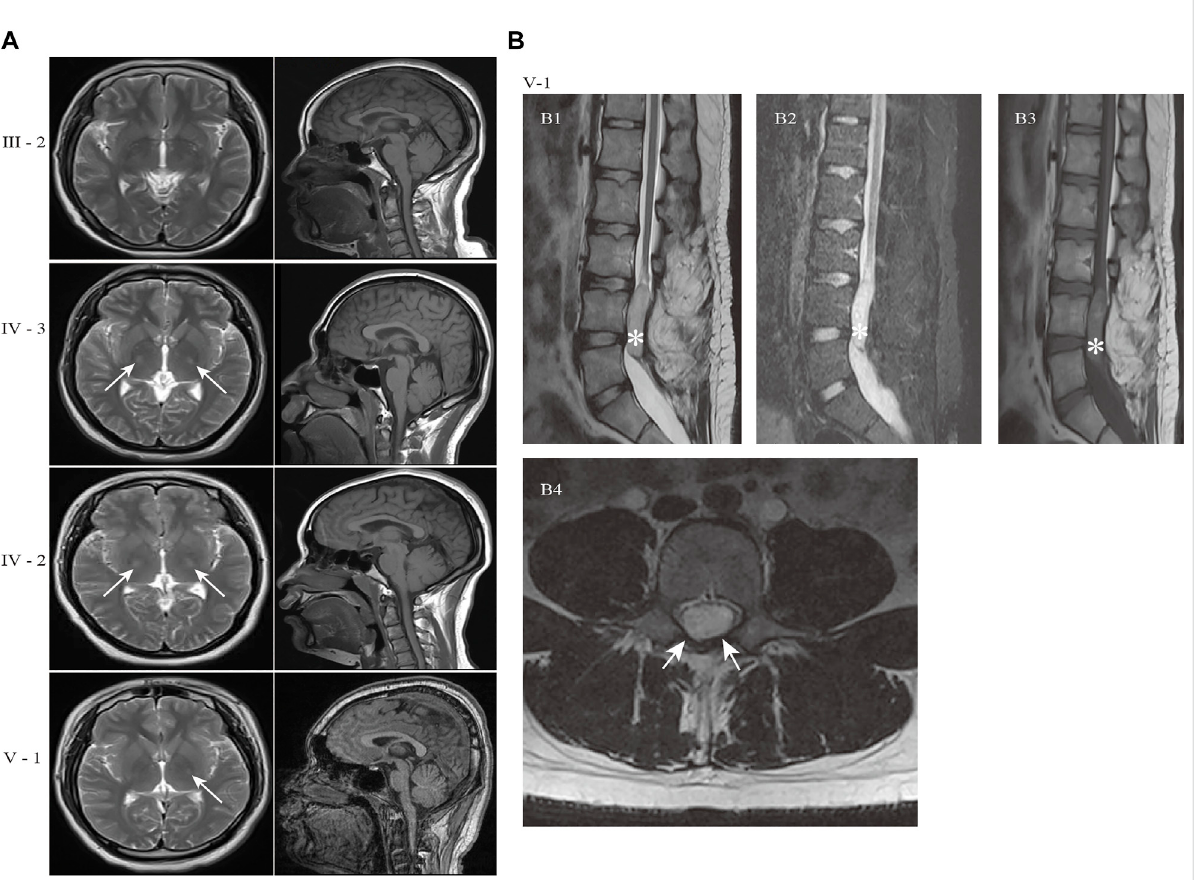
FIGURE 2 Brain and spine MRI of the patients in the HSP family. (A) Axial T2-weighted images and sagittal T1-weighted images of patients. The hyperintensity on the left corticospinal tract pathways were present in proband (V-1). The patient IV-2 and IV-3 showed the bilateral hyperintensities (white arrows). The subjects in this family did not have signs of corpus callosum atrophy. (B) MR image of proband (V-1) showed an oval space- occupying lesion with well-de fi ned boundary in the spinal canal at the corresponding to L4-5 level (white asterisk). (B1) Sagittal T2WI; (B2) Sagittal fat-suppressed T2WI; (B3) Sagittal T1WI; (B4) Axial T2WI. The abnormal signal shadow was uniformity hyperintense signal on T2WI, while no signal reductiononfat-suppressed T2WI(B2).Theshadowshowed nonuniformand inhomogeneoussignals onT1WI(B3). The duralsacwaspartially compressed in B4 (white arrows). Sagittal T2WI: T2-weighted Imaging; T1WI: T1-weighted